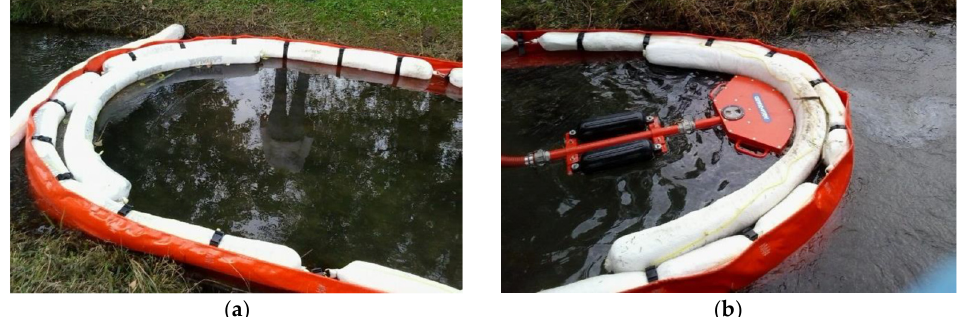
Figure 6. Example of a polypropylene boom ( a ) and oil recovery skimmer ( b ).